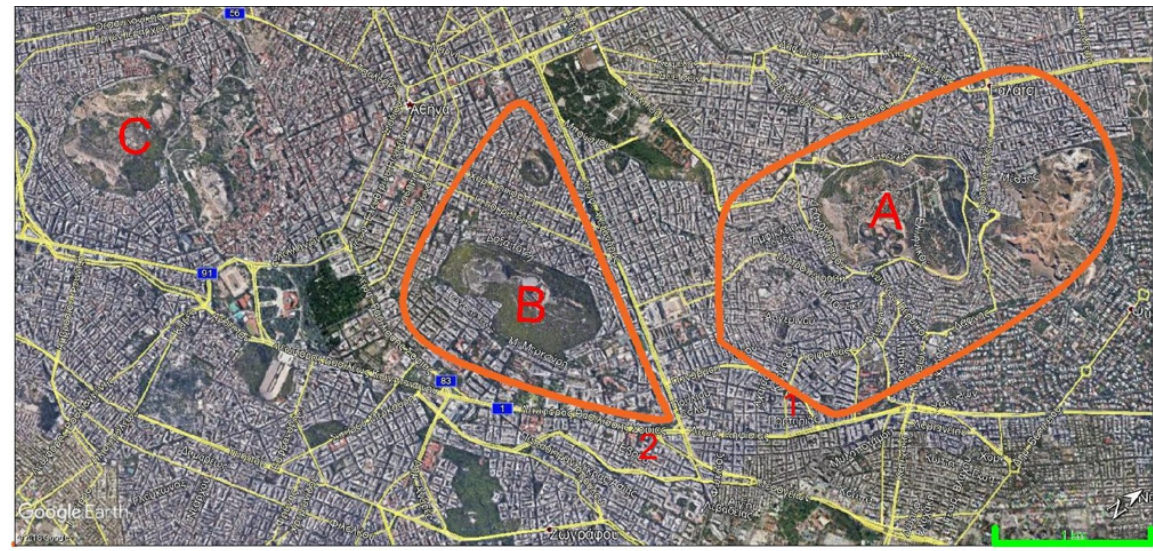
Figure 15: Map of central Athens. 1: “Apollon”, 2: “Tower of Athens”, A: Tourkovounia (hill), B: Lycabettus hill, C: Acropolis hill